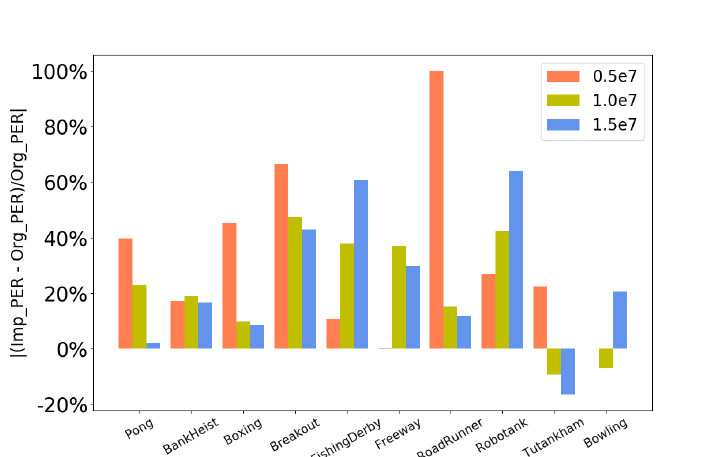
Figure 13. The relative scores achieved by Imp-PER under 5 random seeds. The results shows the relative scores at 0.50 × 10 7 , 1.00 × 10 7 , and 1.50 × 10 7 training steps, respectively.